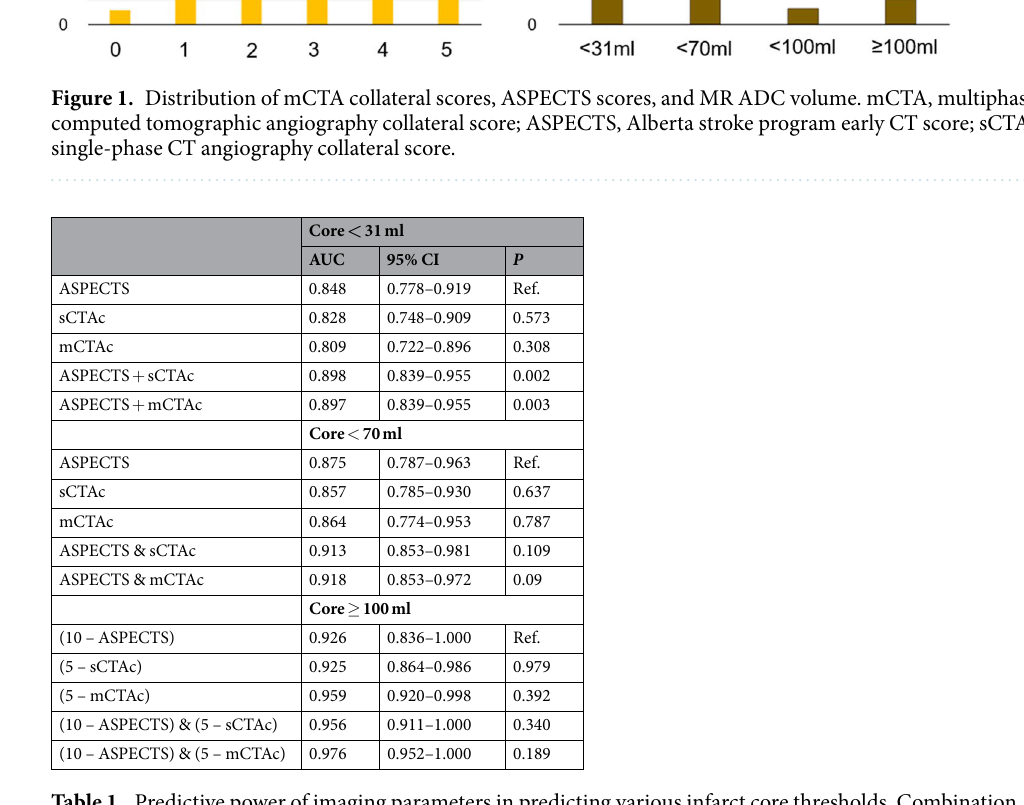
Table 1. Predictive power of imaging parameters in predicting various infarct core thresholds. Combination of ASPECTS scores and collateral scores achieved higher predictive capability for low infarct volumes < 31 ml, as shown by significantly higher AUC values. ASPECTS, Alberta stroke program early CT score; AUC, area under the curve; ADC, apparent diffusion coefficient; sCTAc, single-phase CT angiography collateral; mCTAc, multiphase CT angiography